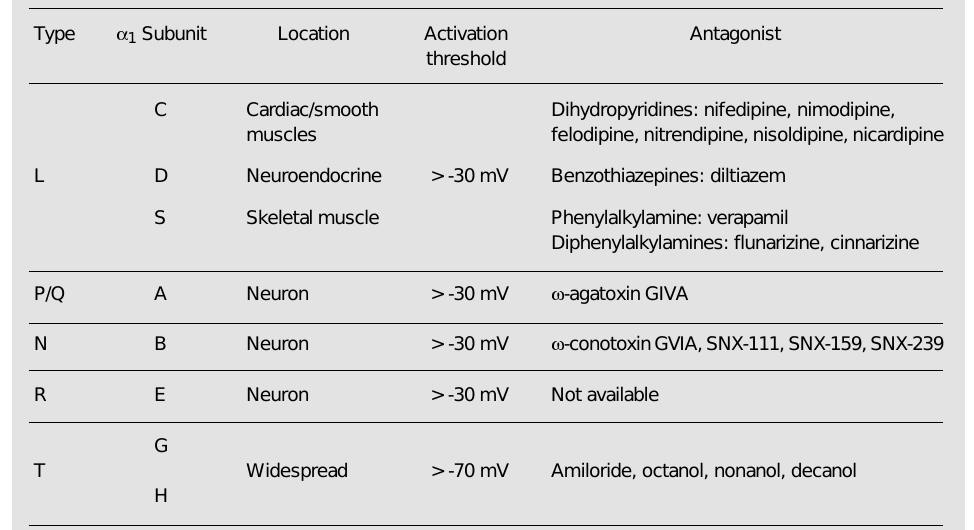
Table 1 - Classification of voltage-operated Ca 2+